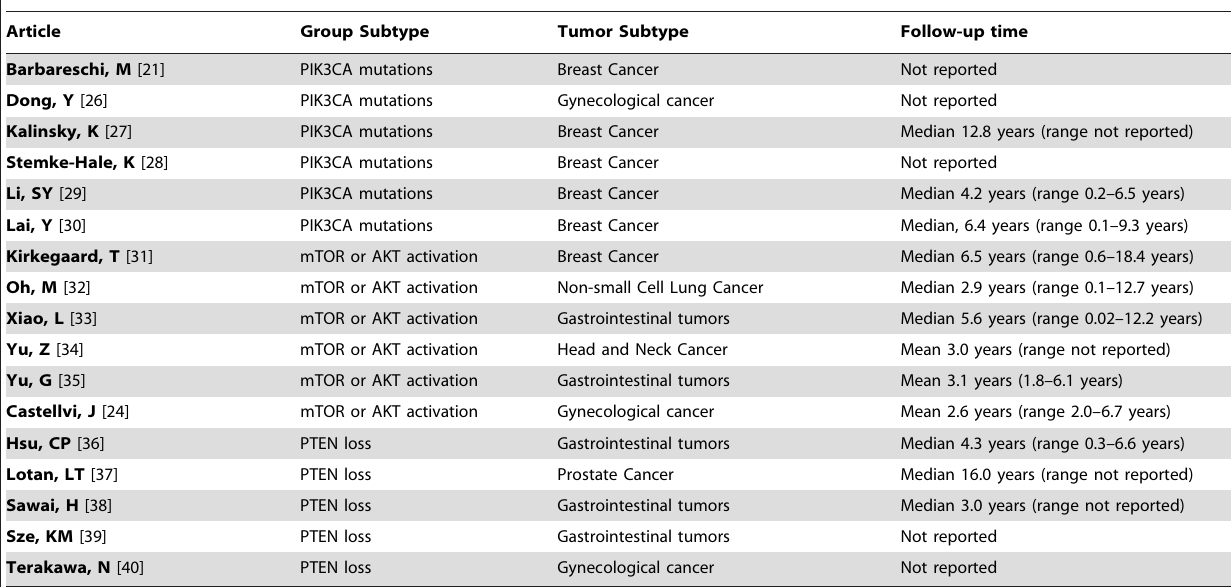
table 1. Six studies evaluated the expression of the PI3K/AKT/ mTOR pathway in breast cancer, five in gastrointestinal tumors, three in gynecological cancers, and one each in prostate, non-small cell lung cancer (NSCLC) and oropharyngeal cancers. Six studies were included in the group called ‘‘mTOR or AKT activation’’,